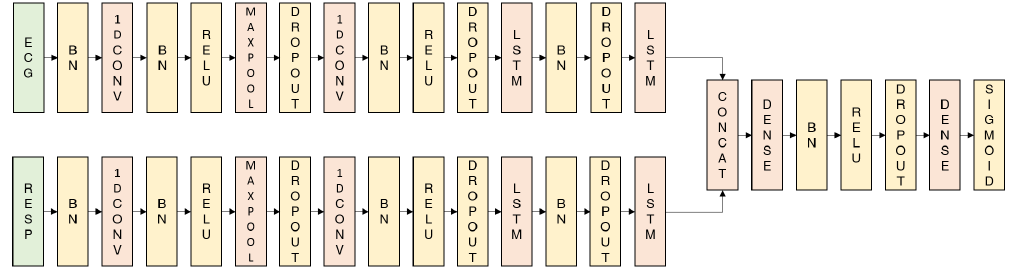
Figure 3. The structure of the proposed DeepER Net. The different signals were processed in each network branch and then concatenated for recognizing the stress. The basic structure is based on the structure of Deep ECG Net